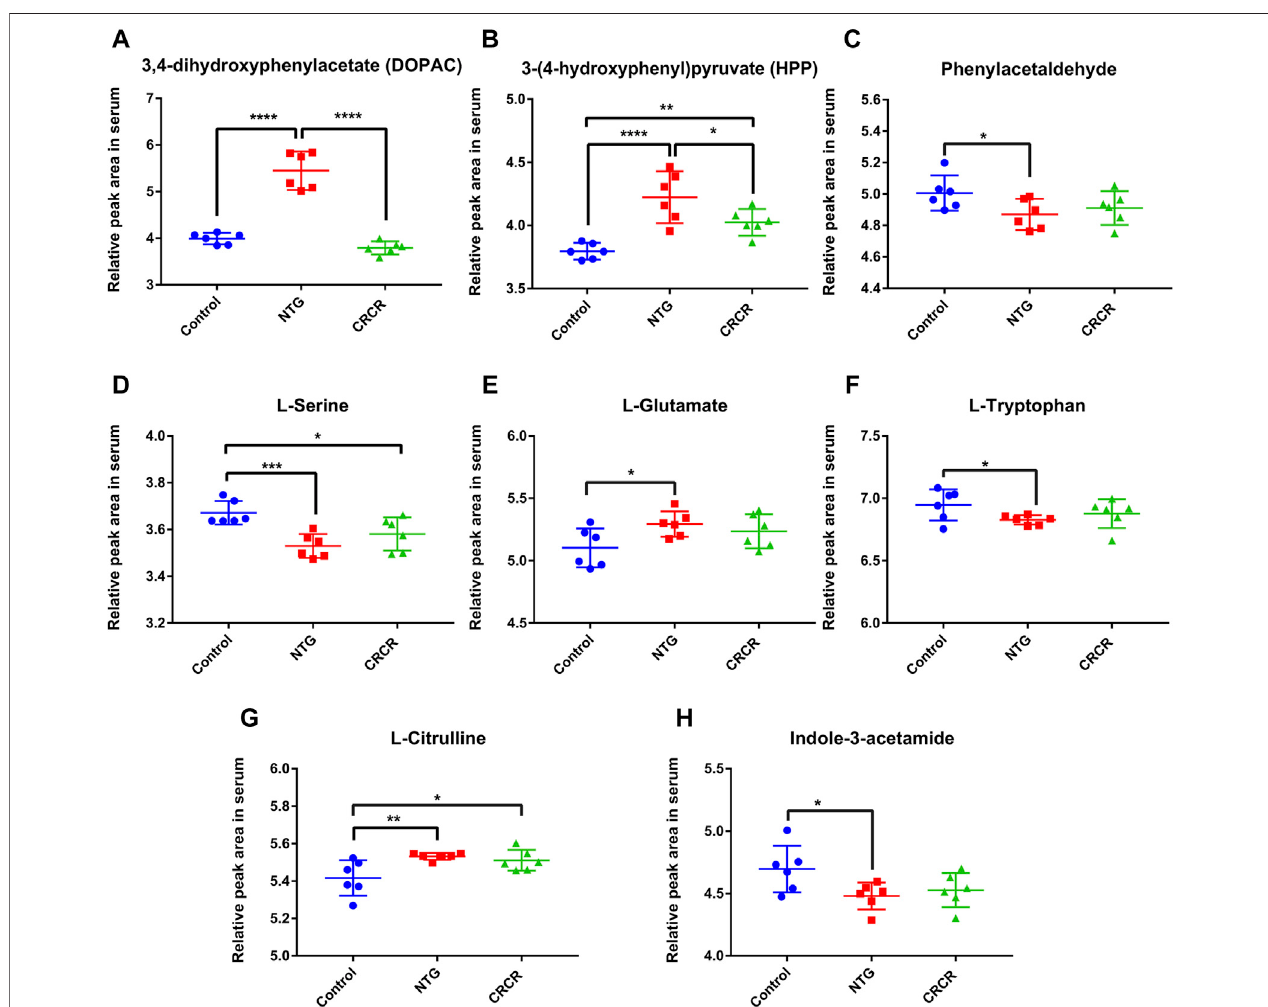
FIGURE 9 | Comparison of relative peak areas of key differentially expressed metabolites in serum. (A) 3,4-Dihydroxyphenylacetate (DOPAC). (B) 3-(4- Hydroxyphenyl)pyruvate (HPP). (C) Phenylacetaldehyde. (D) L-serine. (E) L-glutamate. (F) L-tryptophan. (G) L-citrulline. (H) Indole-3-acetamide. Dataare expressed